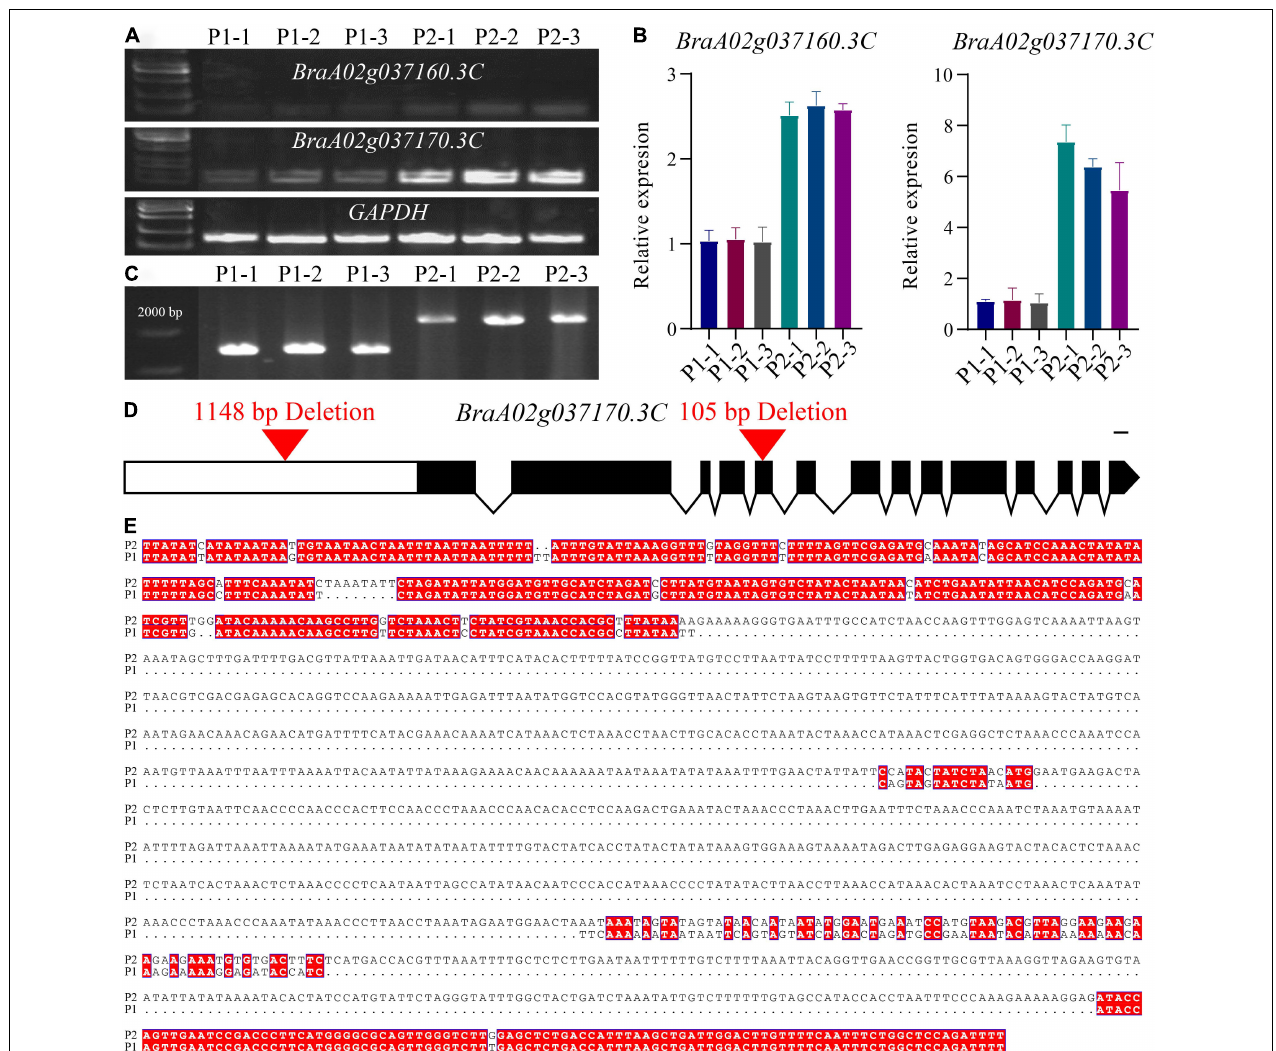
FIGURE 3 | Molecular cloning and confirmation of the BrPYP gene. (A) RT-PCR showing transcript abundance of BraA02g037160.3C and BraA02g037170.3C in the pale-yellow (P 1 ) and yellow petals (P 2 ). GAPDH was used as a control. (B) qRT-PCR showing transcript levels of BraA02g037160.3C and BraA02g037170.3C in the P 1 and P 2 petals. (C) Promoter amplification showing a large deletion in BraA02g037170.3C of P 1 . (D) Schematic representation of the gene structure of BrPYP showing the deletion in the promoter and the fifth exon of the pale-yellow parent. Introns are represented by a line, and exons are represented by black boxes. (E) The promoter was then sequenced and aligned (from 978 bp upstream to 2,500 bp) between P 1 and P 2